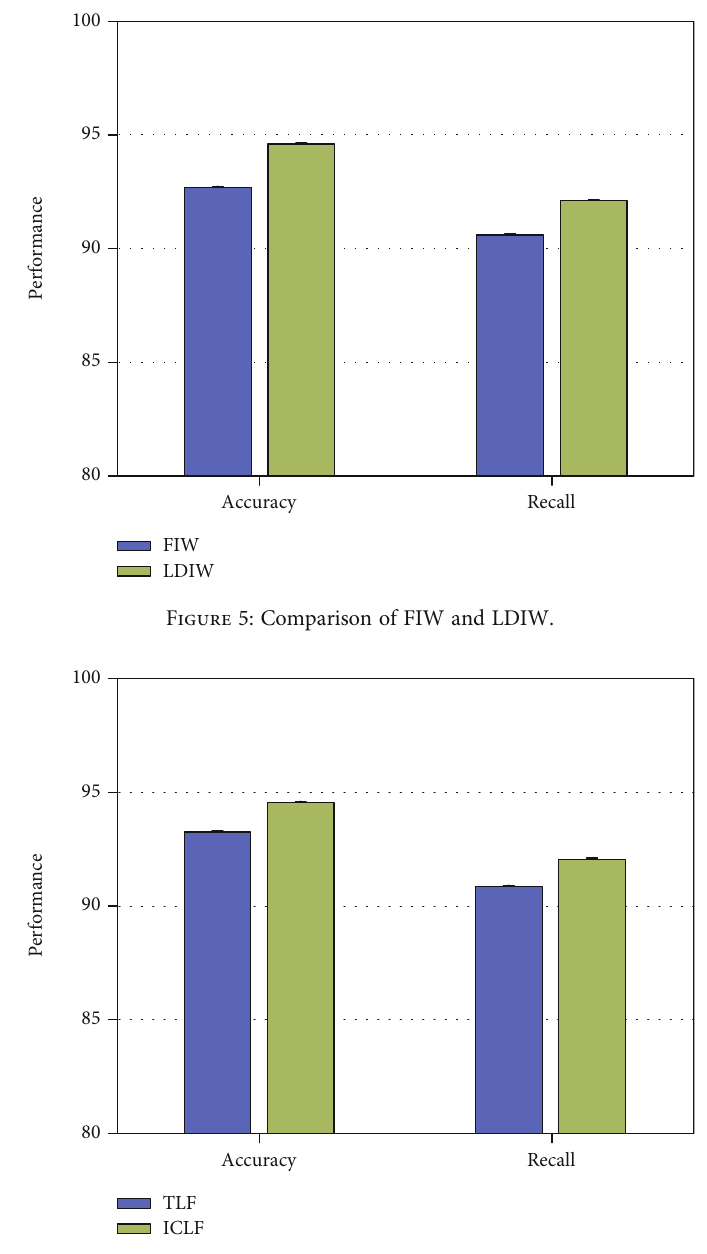
Figure 6: Comparison of TLF and